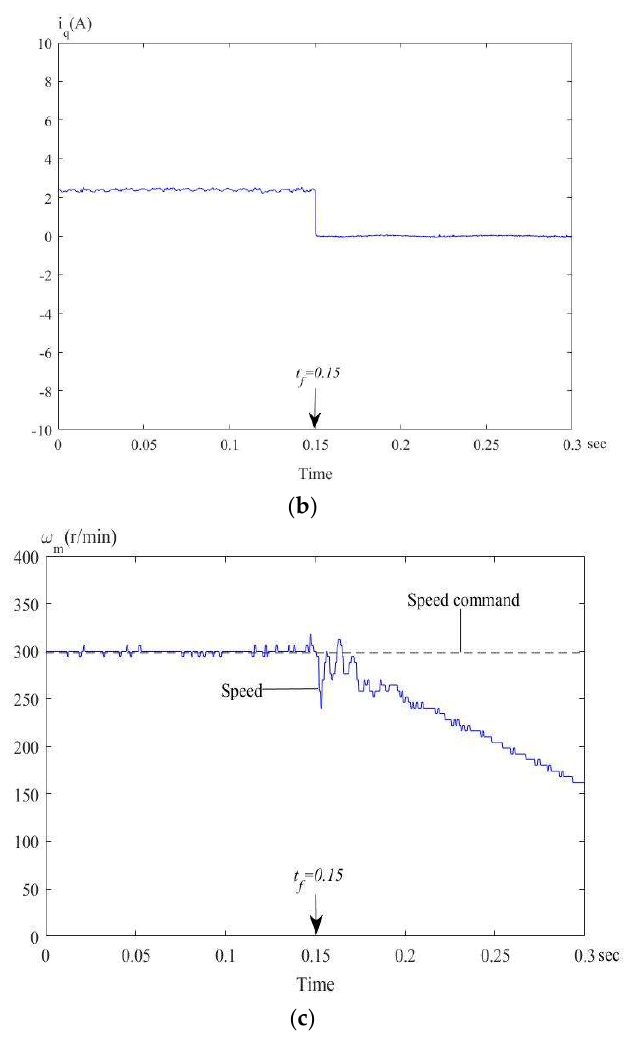
Figure 18. Measured results when the a -phase was short-circuited without using the fault-tolerant method: ( a ) three-phase currents; ( b ) q -axis current; ( c ) speed response.